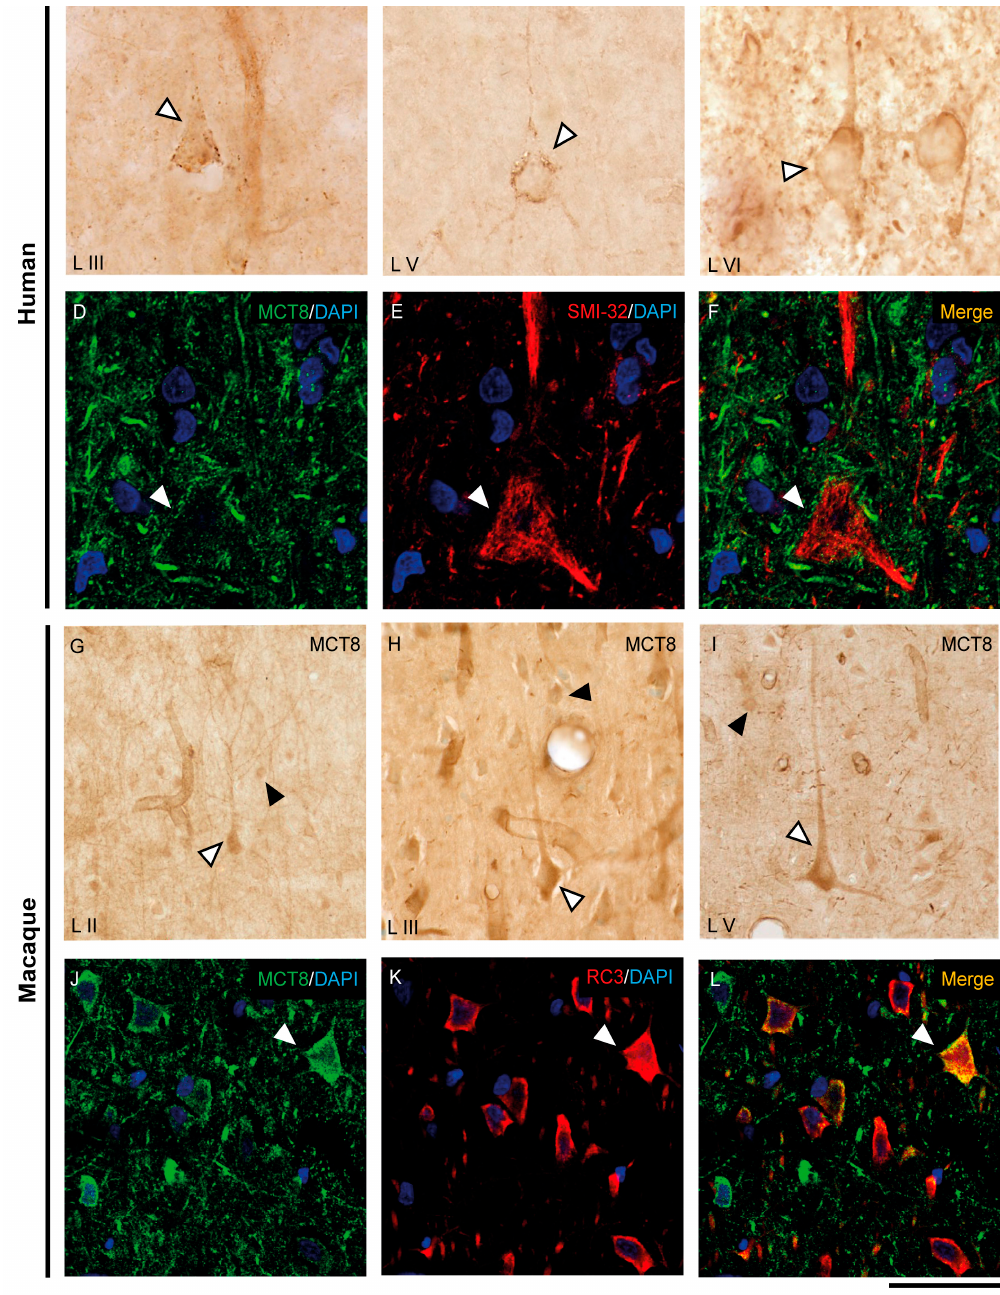
Figure 3. Expression of MCT8 in pyramidal neurons of the human and macaque motor cortex. Representative brightfield photomicrographs show immunostaining for MCT8 in layers III ( A ), V ( B ) and VI ( C ) of the human motor cortex, and layers II ( G ), III ( H ), and V ( I ) of the macaque motor cortex. White arrowheads point to pyramidal neurons with immunopositive signal in the soma, apical and basal dendrites. Black arrowheads point to smaller cells with the morphology of interneurons. ( D – F ) (human) and ( J – L ) (macaque) show confocal microscope images from double-stained sections for MCT8 (green) and the pyramidal neuron markers SMI-32 (red) for 200 kDa neurofilament protein or neurogranin/RC3 (red), respectively. White arrowheads point to pyramidal neurons. Counterstaining with DAPI (blue) shows nuclei of all cells. Note that in humans, the MCT8 signal is located mainly in the pyramidal cell membrane, while in macaques it is located in the membrane and the cytoplasm. Scale bar = 50 µ m ( A ), 120 µ m ( B , I ), 25 µ m ( C – F ), 60 µ m ( G ), 62.5 µ m ( H ), and 43.5 µ m ( J – L